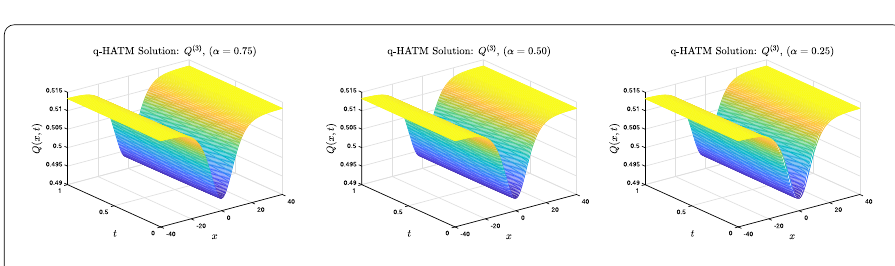
Figure 4 q-HATM Q (3) -solution with different α when (cid:2) = –1, k = η = 0.1, r = –1.5, p = 1.5, and n = 1 for Example 4.1